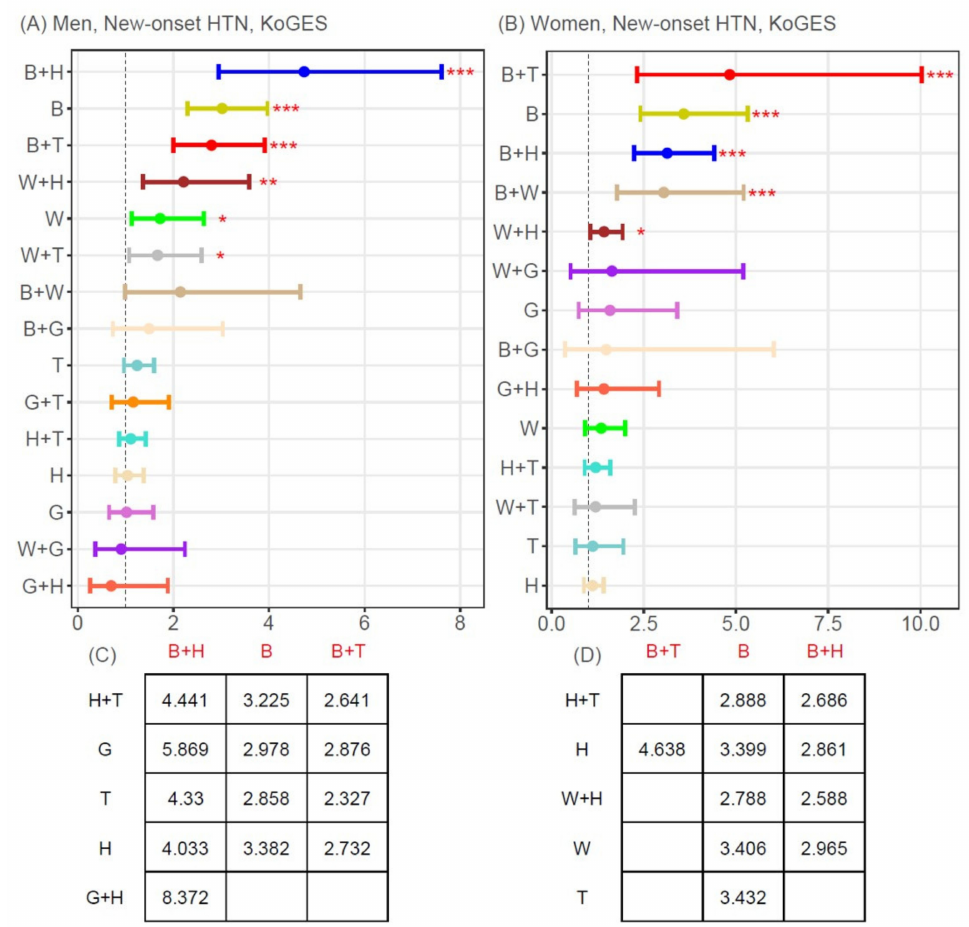
Figure 4. Adjusted hazard ratios and 95% confidence intervals for new-onset hypertension. ( A , C ) men, ( B , D ) women. ( A , B ) Hazard ratios and 95% confidence intervals for the risk of new-onset hypertension of each single MetSyn component and two-component combination, compared with non-MetSyn, based on multivariate Cox regression analysis after adjusting for age, body mass index, smoking, and alcohol intake. Closed circles represent adjusted hazard ratios, and short vertical bars indicate the lower and upper limits of the 95% confidence interval for new-onset hypertension. ( C , D ) Adjusted hazard ratios for new-onset hypertension when setting the rows (black color; e.g., B+H, G, T]) and columns (red color; e.g., B+H, B, B+T) as reference and comparison groups, respectively. Of the 105 possible unique comparisons (based on a 15 × 15 matrix), adjusted hazard ratios are shown for only those comparisons with a Bonferroni-corrected p -value < 4.79 × 10 − 4 (=0.05/105). * p < 0.05, ** p < 0.01, *** p < 0.001. B, elevated blood pressure; G, elevated glucose; H, low HDL-cholesterol; HTN, hypertension; KoGES, Korean Genome and Epidemiology Study Ansan and Ansung; MetSyn, metabolic syndrome; T, elevated triglycerides; W, increased waist